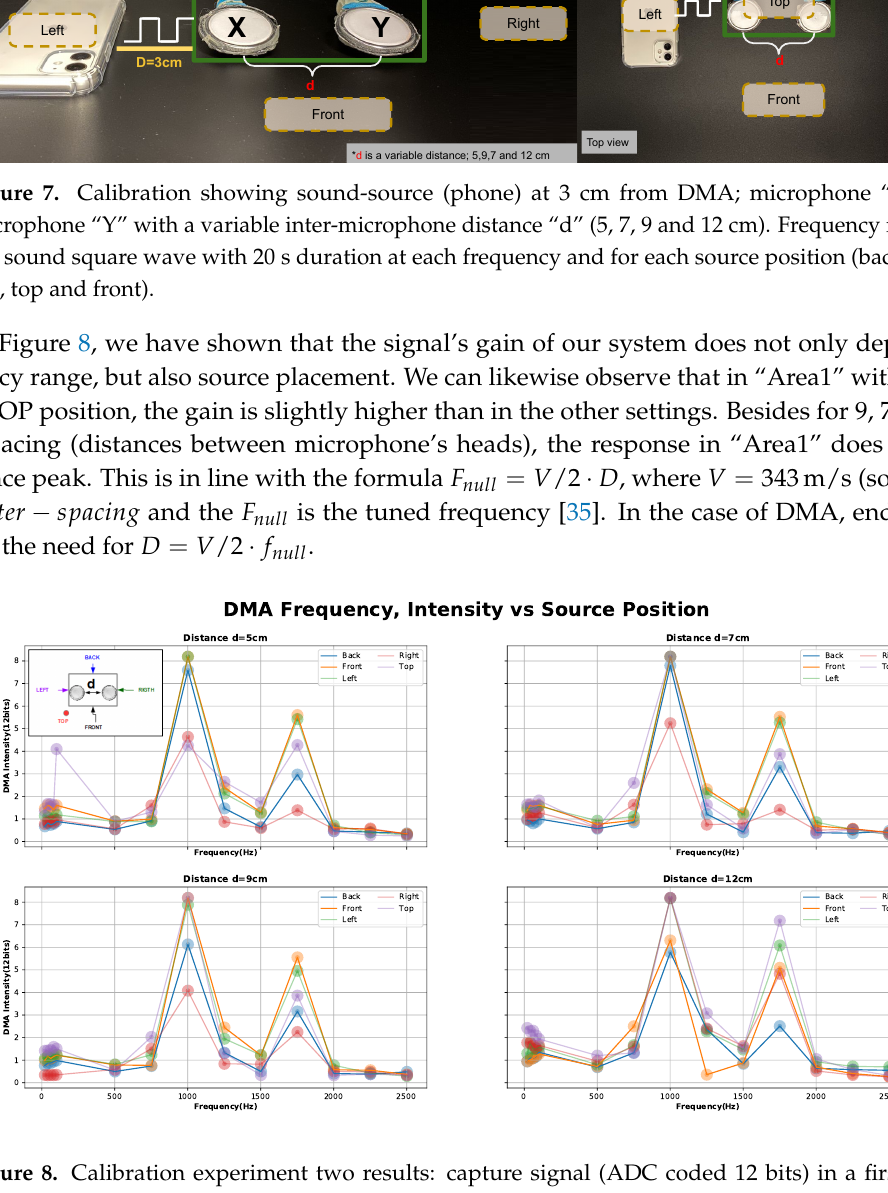
Figure 8. Calibration experiment two results: capture signal (ADC coded 12 bits) in a first order Differential Microphone Array (DMA) configuration between source positions (top, back, front, right and left) for “Area1” = Low-freq (21–751 Hz), Area2 = Middle-freq (1001–1751) and Area3 = High-freq